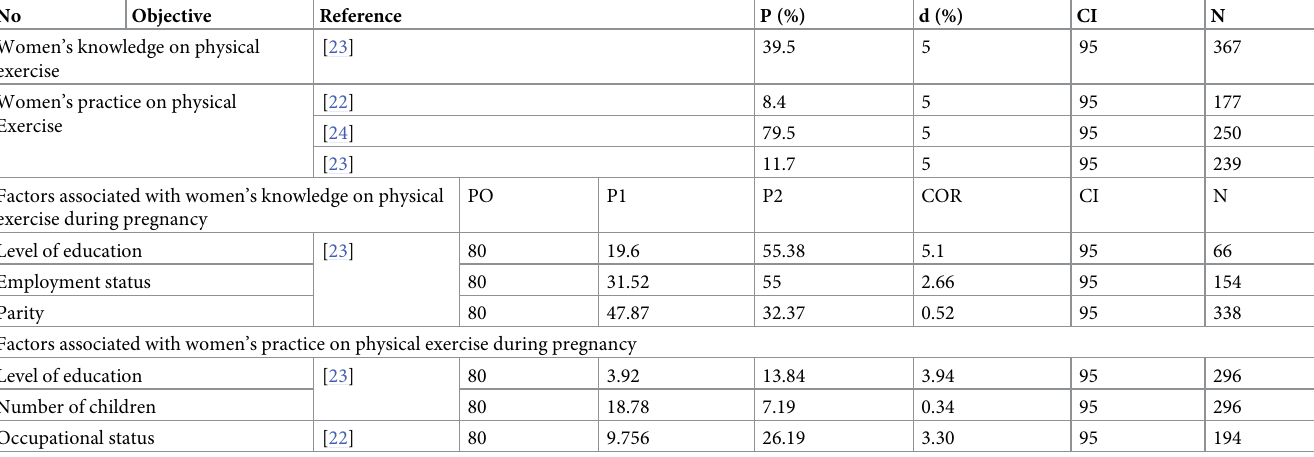
Table 1. Sample size calculation of antenatal physical exercise level and its associated factors among pregnant women in Hawassa city, Sidama Regional State, Ethi- opia,